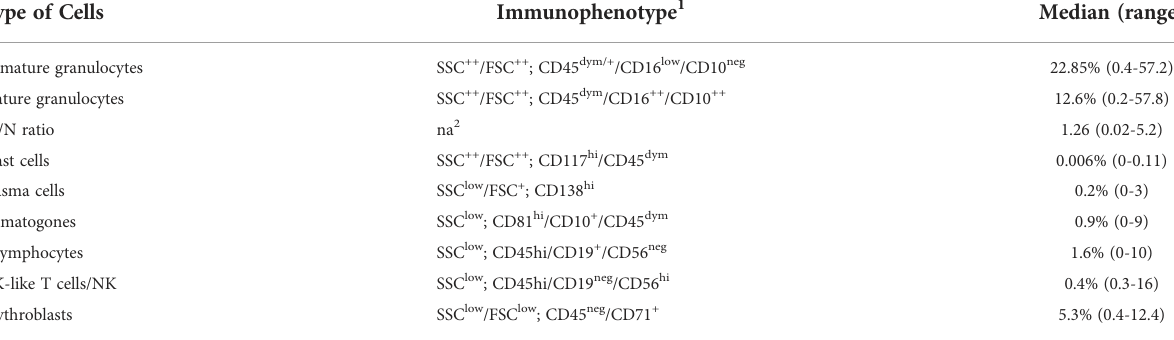
TABLE 3 Flow cytometry de fi nition of BM cell populations. Distribution of the main BM cell populations, according to their immunophenotype. Type of